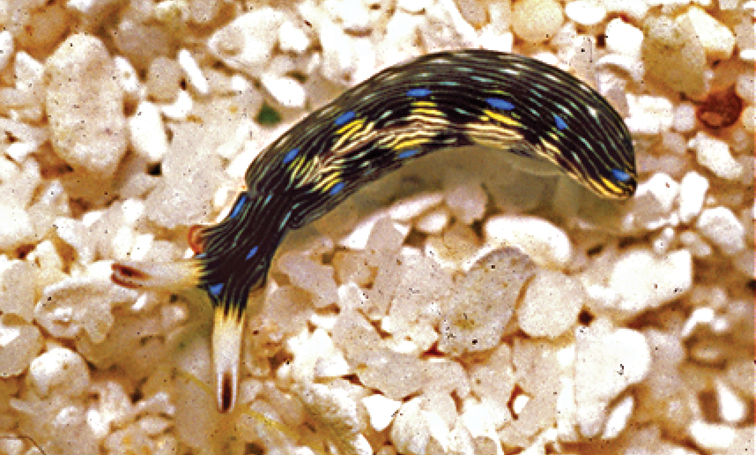
Thuridilla gracilis form bayeri, Maldives, photo: J Hinterkircher (no spcm).